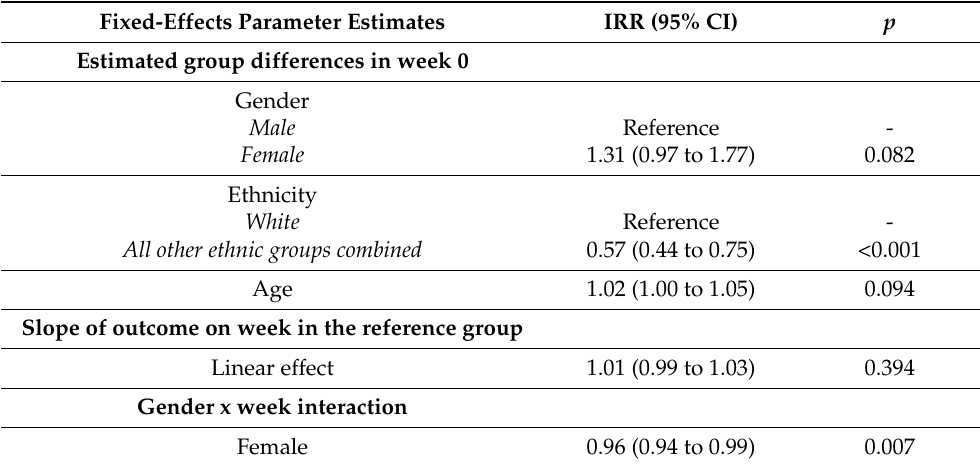
Figure 1. Trajectory of steps walked per week. The vertical dashed line indicates easing of lockdown restrictions (11 May 2020). Table 3. Fixed-effects parameter estimates from the final trajectory model for miles run per